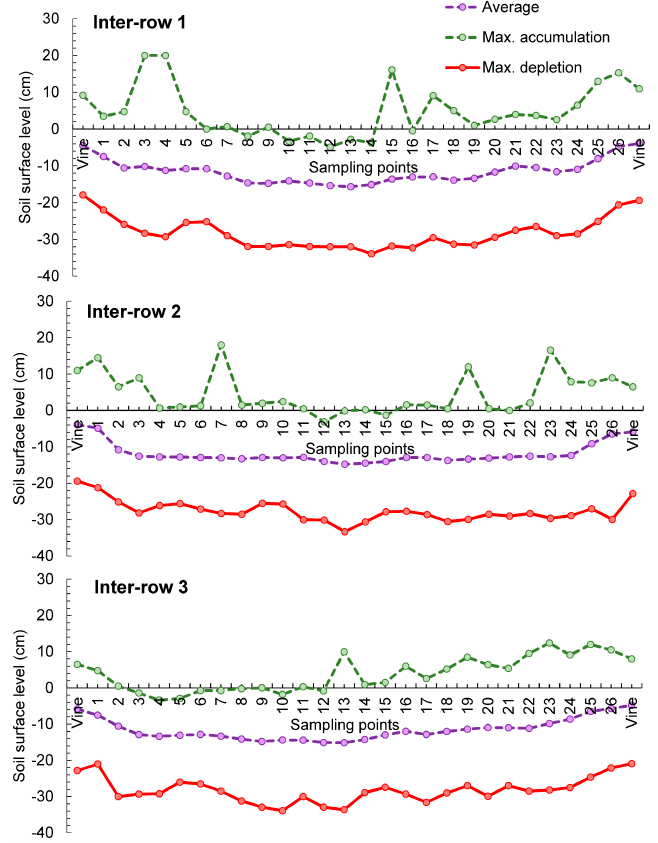
Figure 4. Average values, maximum accumulation, and depletion in each inter-row area.